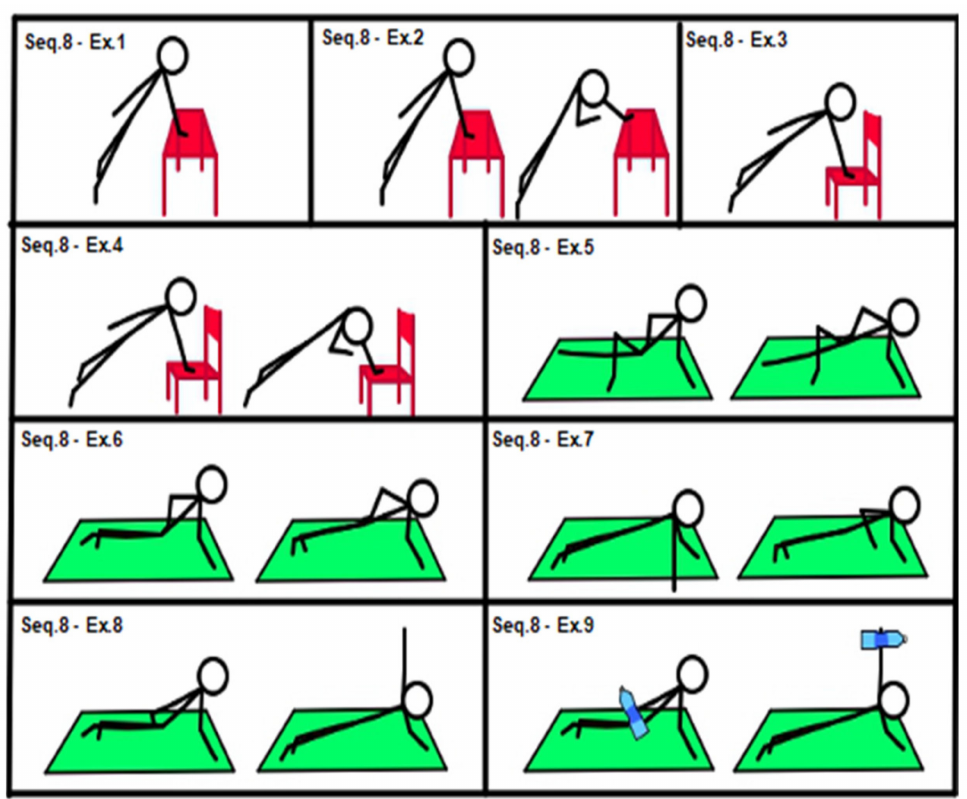
Figure 8. Sequence 8: core stability, high